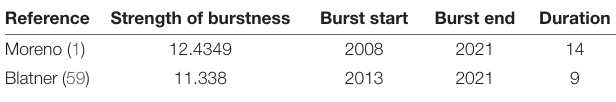
TABLE 1 | Metrics of major clusters identified by document co-citation analysis. Cluster ID